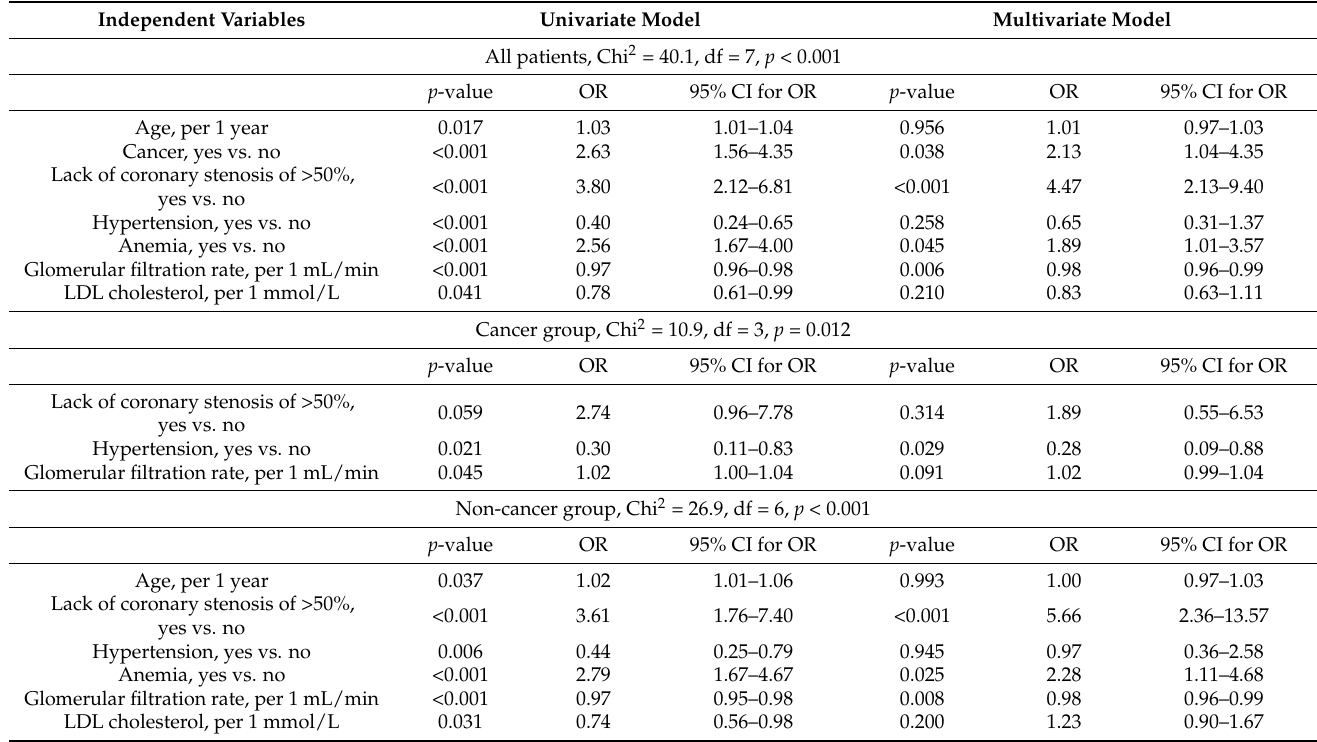
Hypertension and LDL cholesterol as traditional cardiovascular risk factors were associated with more frequent use of statins, but only in a univariate